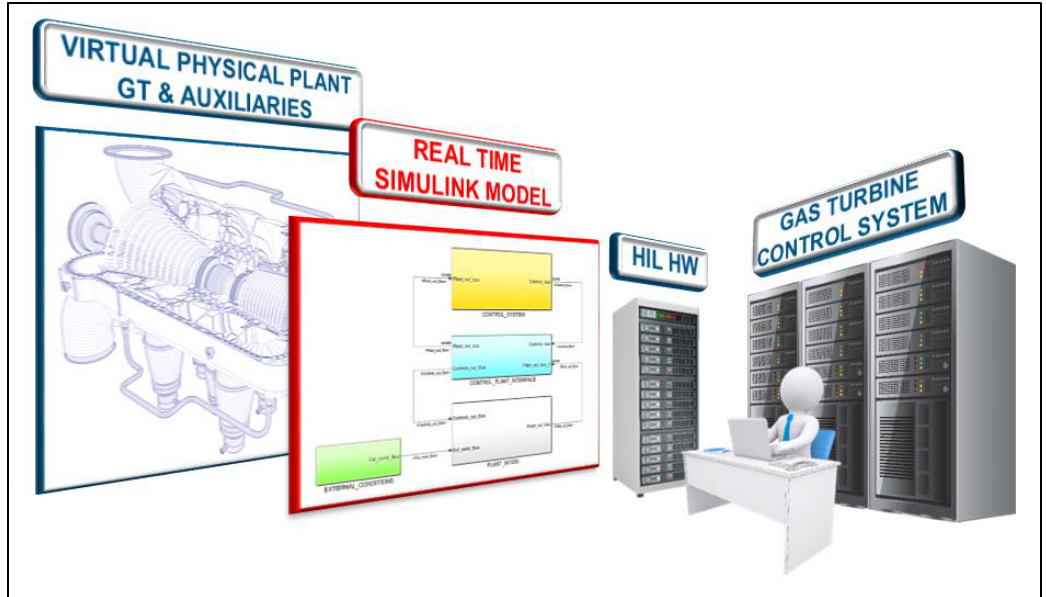
Figure 1. Gas turbine (GT) control system validation and verification by Hardware in the Loop (HIL) testing and simulated physical plant.